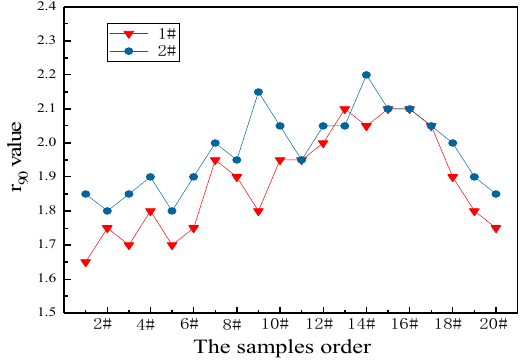
Figure 9. Comparison of r 90 values.